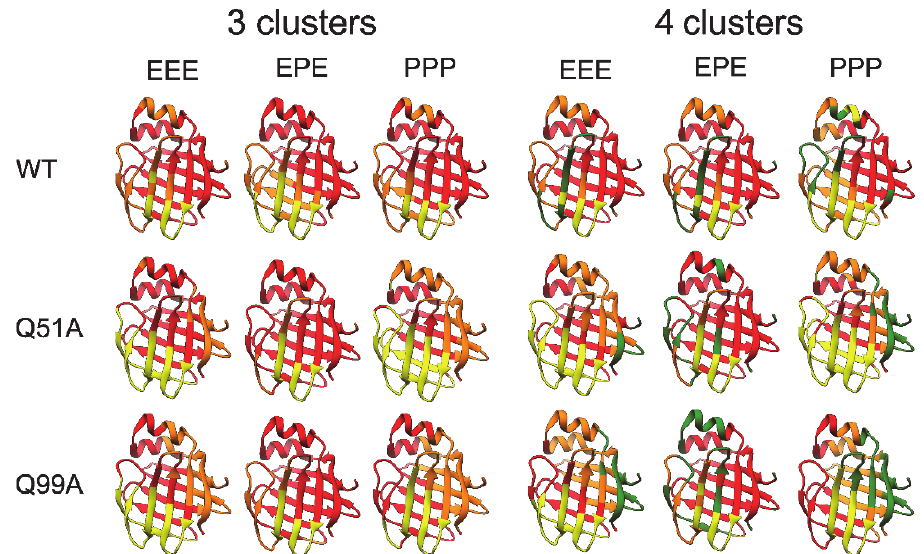
Figure 11. Correlated motions in the investigated apo human I ‐ BABP variants as revealed by MD simulations for different protonation states (E: neutral, P: cationic His side chain of residues H52, H57, and H98). Clustering of regions for ‘slow’ correlated motions at 283 K was based on the analysis of alterations of pairwise distances between C α atoms and splitting the residues moving together into three or four clusters. Clusters are represented by different colors on the ribbon diagram of apo human I ‐ BABP (PDB: 1O1U [15]).